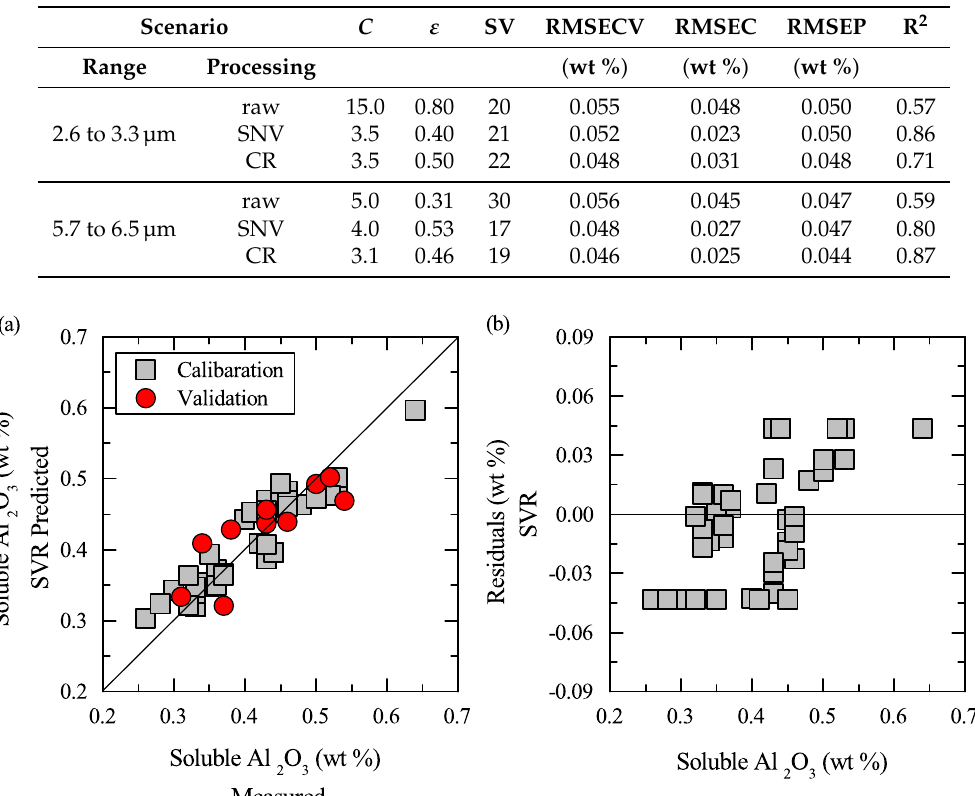
Figure 9. ( a ) Measured vs. Predicted plot of the SVR model for the 5.7 to 6.5µm range after CR processing. C = 3.1, ε = 0.46, SV = 19 in the calibration and validation samples. ( b ) Residuals plot of the SVR